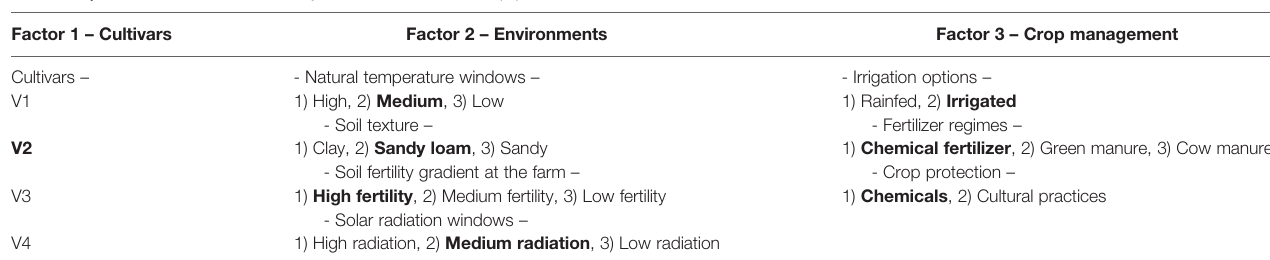
TABLE 2 | Factors involved in a GEM system at a broadacre crop production farm.